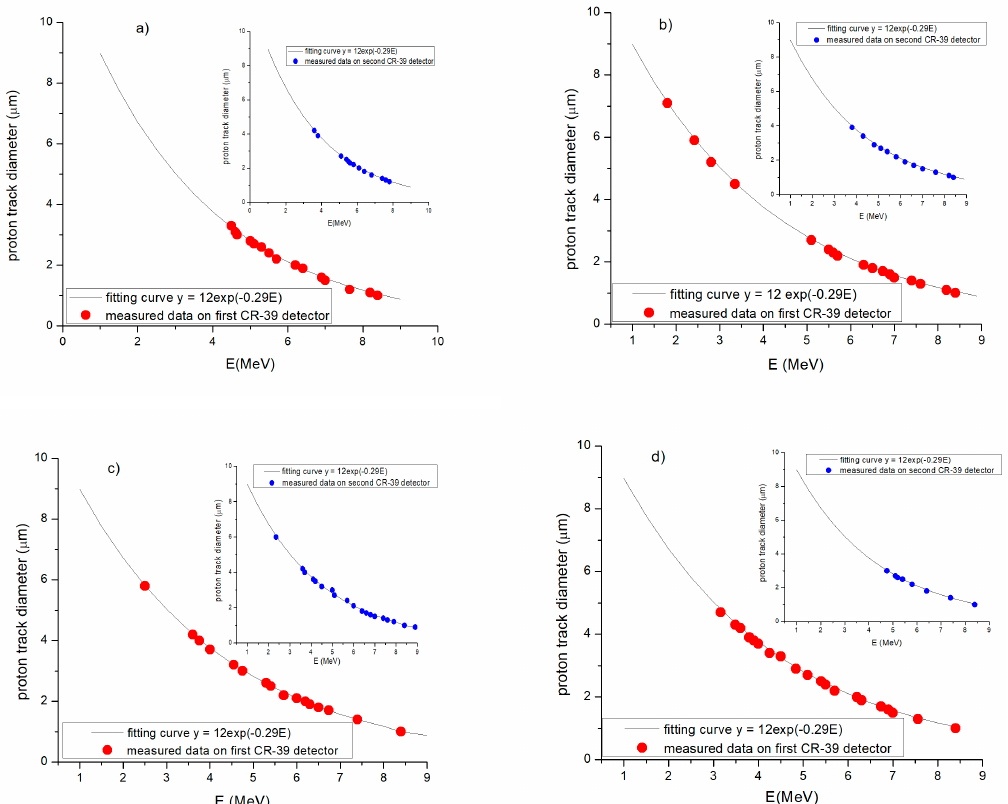
Figure 8. Evolution of proton track diameters on first (red points) and second (blue points) post-etched CR-39 detector, as it results from the AFM images for: ( a ) 5 µ m thick Ag target; ( b ) 5 µ m thick Al target; ( c ) 10 µ m thick Ag target; ( d ) 10 µ m thick Al target. The black line represents the fitting curve.